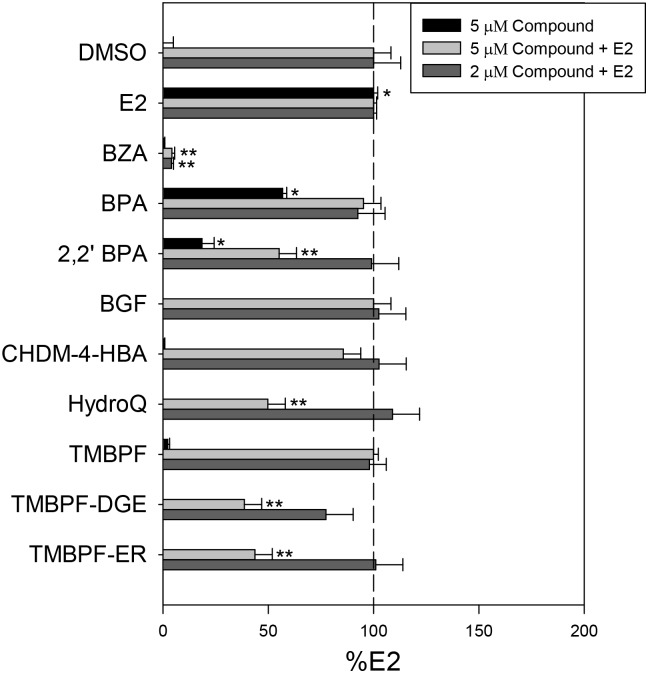
Chemical compound effect on an integrated ERE-driven luciferase reporter in the ER responsive MCF-7 cell line.MCF-7-MAR-ERE-Luc were treated with indicated compounds at 5 μM, 5 μM + 10 nM E2, or 2 μM + 10 nM E2 for 24 hours before total luciferase activity determined. The %E2 calculated using control wells treated with E2 (10 nM) or DMSO. Dashed line indicates 10 nM E2 control response. All data represent mean of 3 experiments ± standard deviation. (*) or (**) indicates a response significantly (p < 0.05) above or below control treatment.